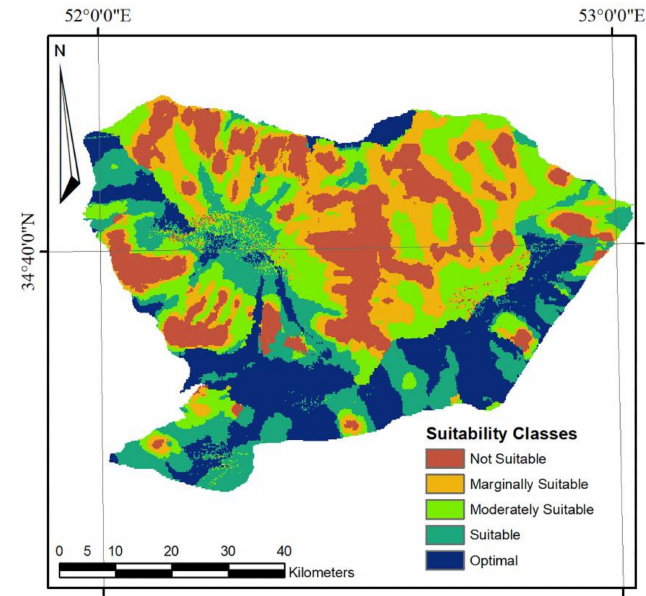
Figure 13. Suitability of Kavir National Park for runo ff harvesting.